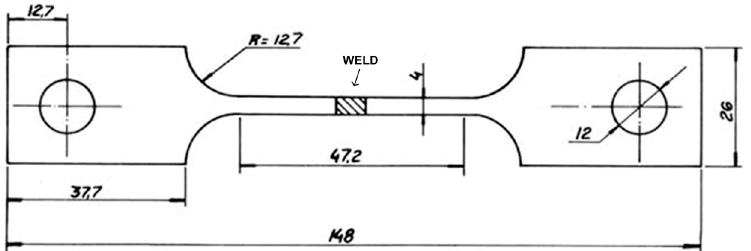
Figure 1. Design of the smooth tensile specimen used in stress corrosion cracking (SCC) tests (unit: mm).